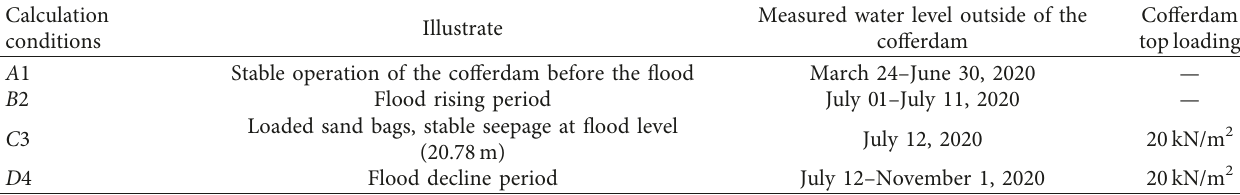
Table 2: Load combinations for cofferdam stability analysis.